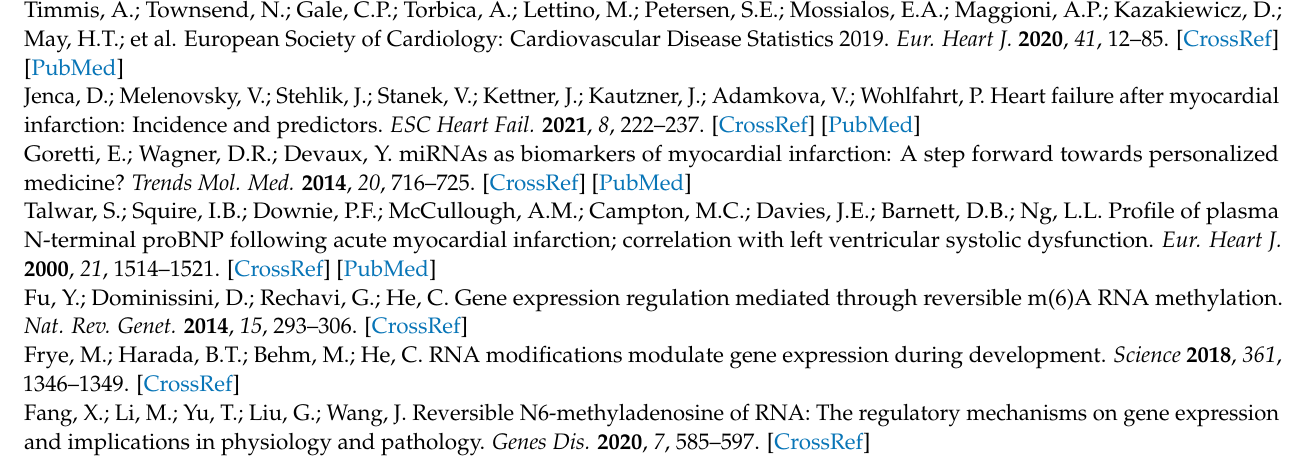
Figure S1: calibration curve using m6A standards by LC-MS; Figure S2: Echocardiographic images, videos and parameters in rats 1 h after surgery; Figure S3: FTO protein quantification by Western Blot; Video S1: Movie 1-sham; Video S2: Movie